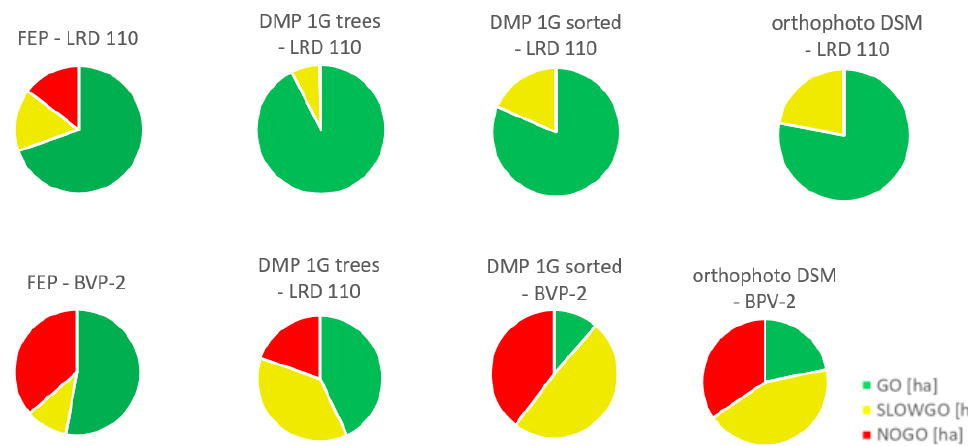
Figure 6. The ratio of passability of the selected Forest Bačetín for a light wheeled vehicle Land Rover Defender 110 (LRD 110) and armored tracked vehicle BVP-2; CCM analysis processed with data FEP, DSM 1G tree positions, and orthophoto DSM based data.